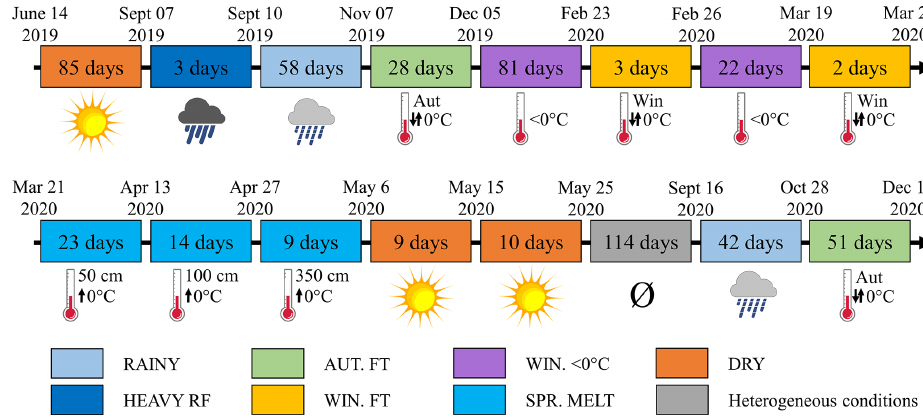
Figure 6. Targeted weather conditions for each scan survey period, 14 June 2019–18 December 2020